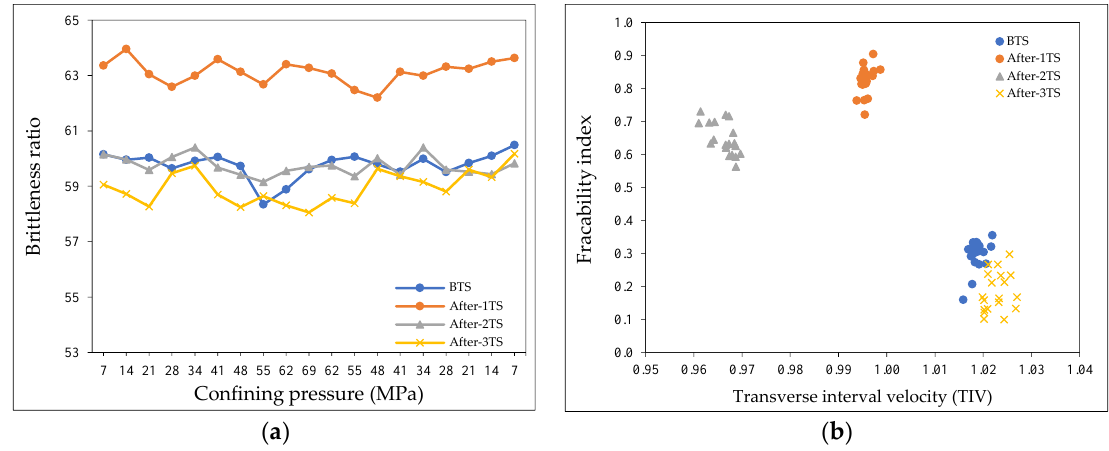
Figure 8. ( a ) Young’s modulus results of EF#5 at different confining pressures before and after thermal shock; and ( b ) Poisson’s ratio results of EF#5 at different confining pressures before and after thermal shock.